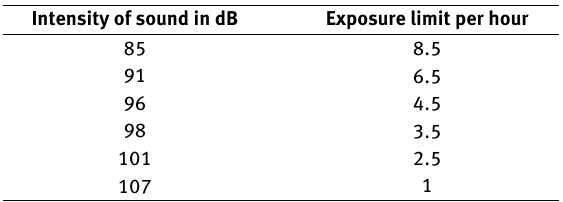
Table 1: Exposure limits of safety defined by Health act Intensity of sound in